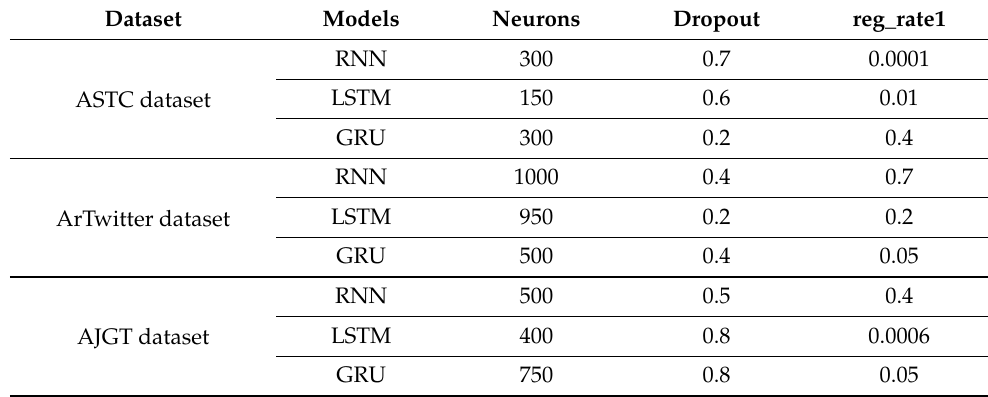
Table 1. The best values parameters of DL models for each dataset.